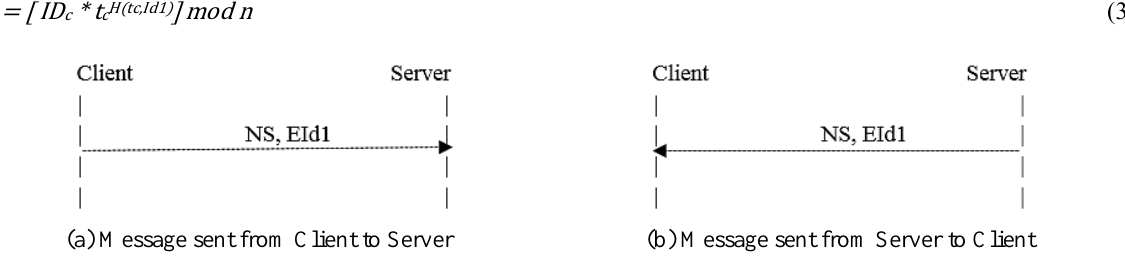
Figure 4. Client – Server Message Exchange.